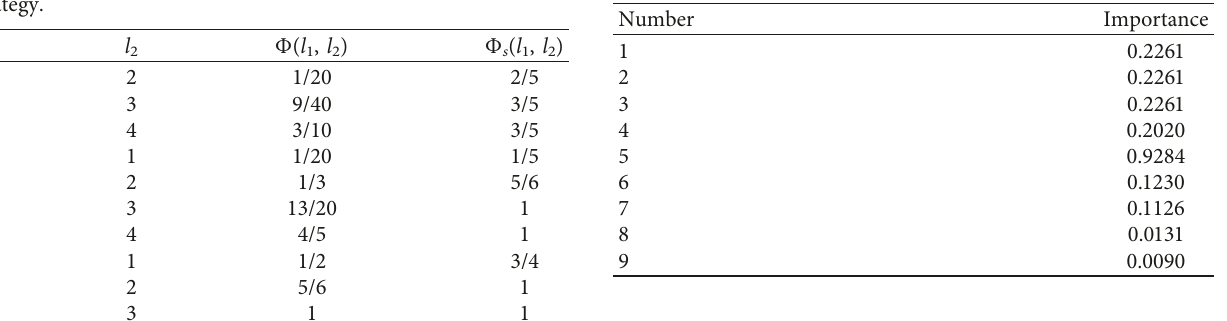
Table 9: Importance of components in Example 1.